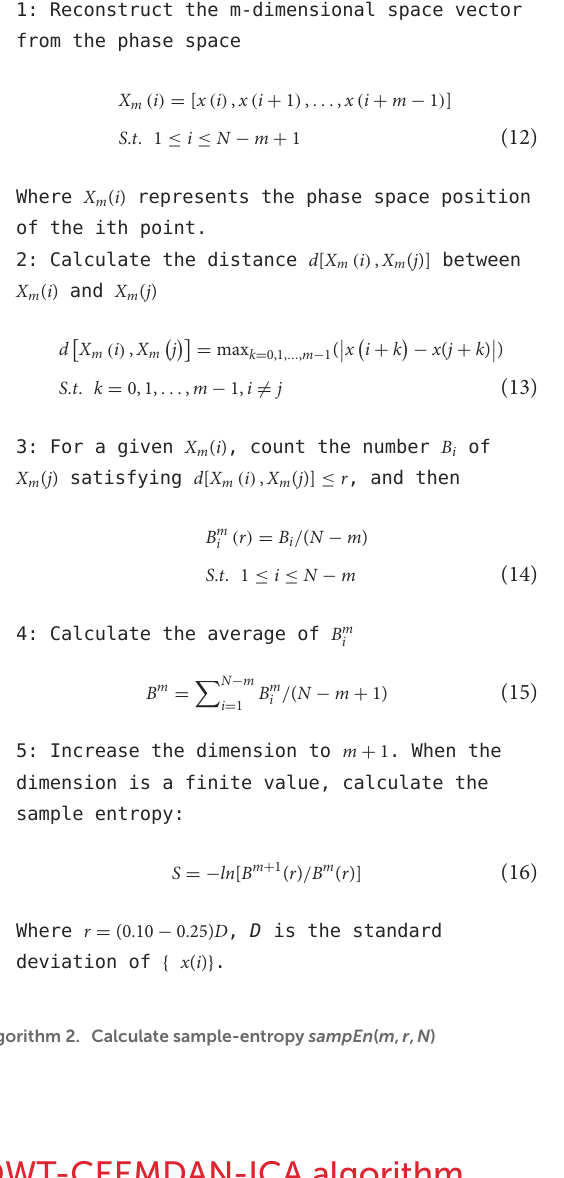
Algorithm 2 (Calculate sample-entropy) to remove the EOG